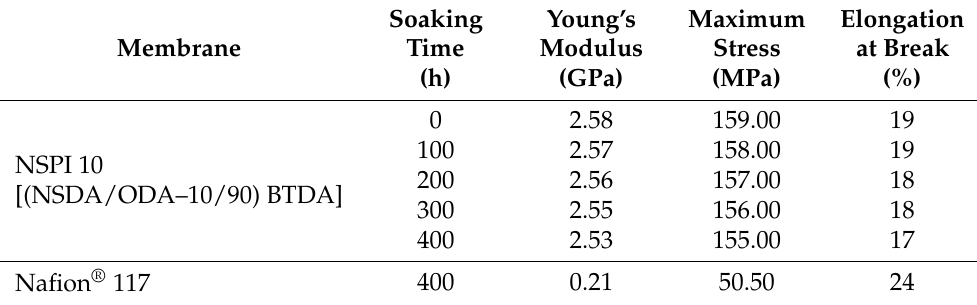
Table 3. Comparison of NSPI 10 and Nafion ® 117 mechanically.